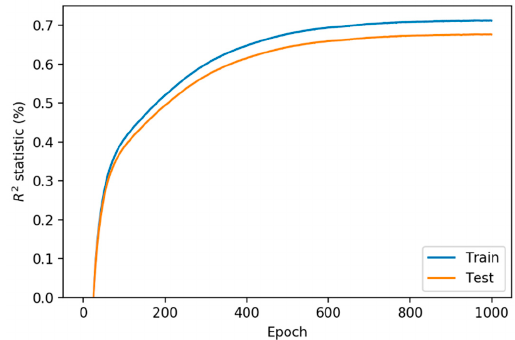
Figure 6. Variation of the coefficient of determination R 2 vs. epochs for neural network architecture of 1 hidden layer, 2 neurons.